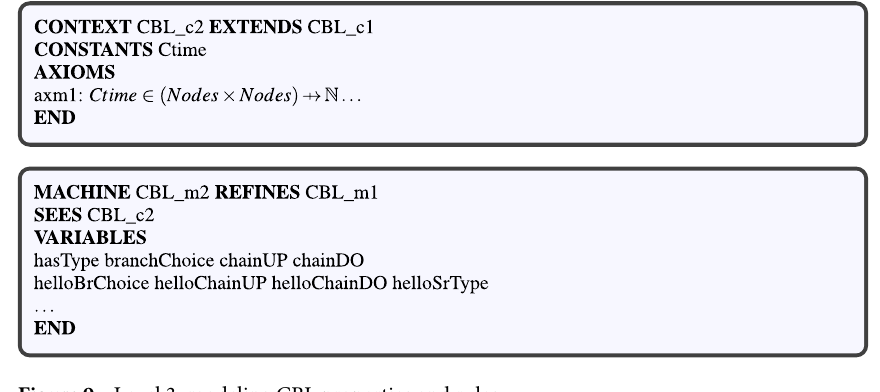
Figure 9. Level 3: modeling CBL properties and rules.